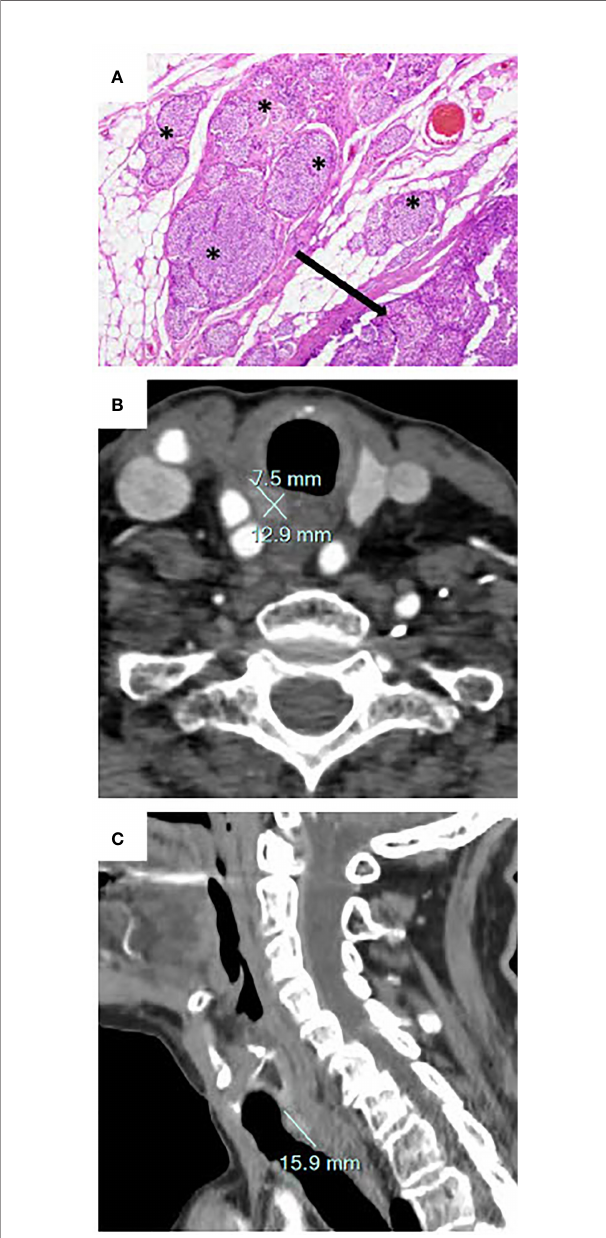
FIGURE 1 | (A) Original histology showing the main mass (arrow) and tumoral nests (*) that extend into the adipose tissue. This invasion, together with vascular invasion, mitotic fi gures, and necrosis is indicative for a low- grade parathyroid carcinoma (hematoxylin & eosin staining, 40X). (B, C) Cervical computed tomography demonstrating a right retro-tracheal mass of 15.9 x 12.9 x 7.5 mm corresponding to local recurrence of the incompletely resected parathyroid